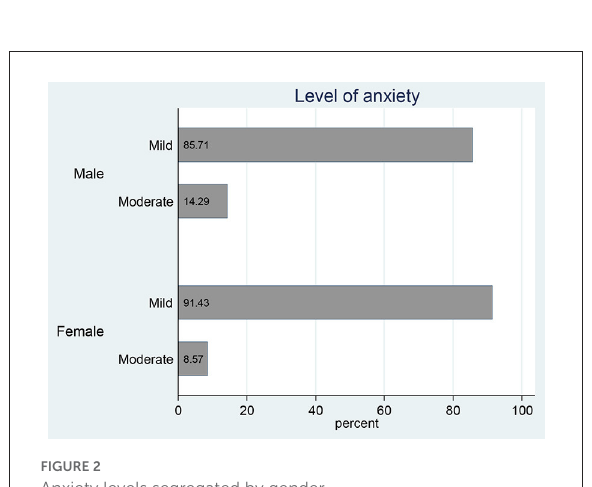
FIGURE2 Anxiety levels segregated by